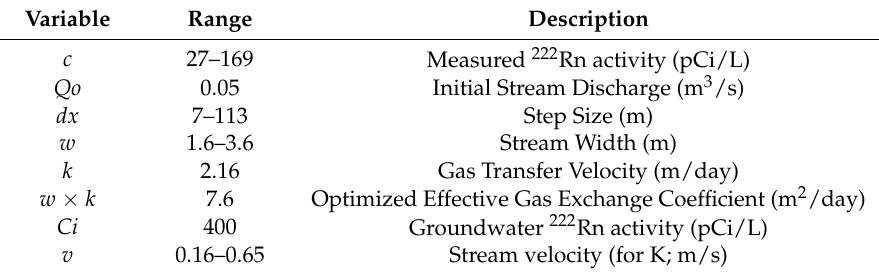
Table 3. Parameters used to model groundwater